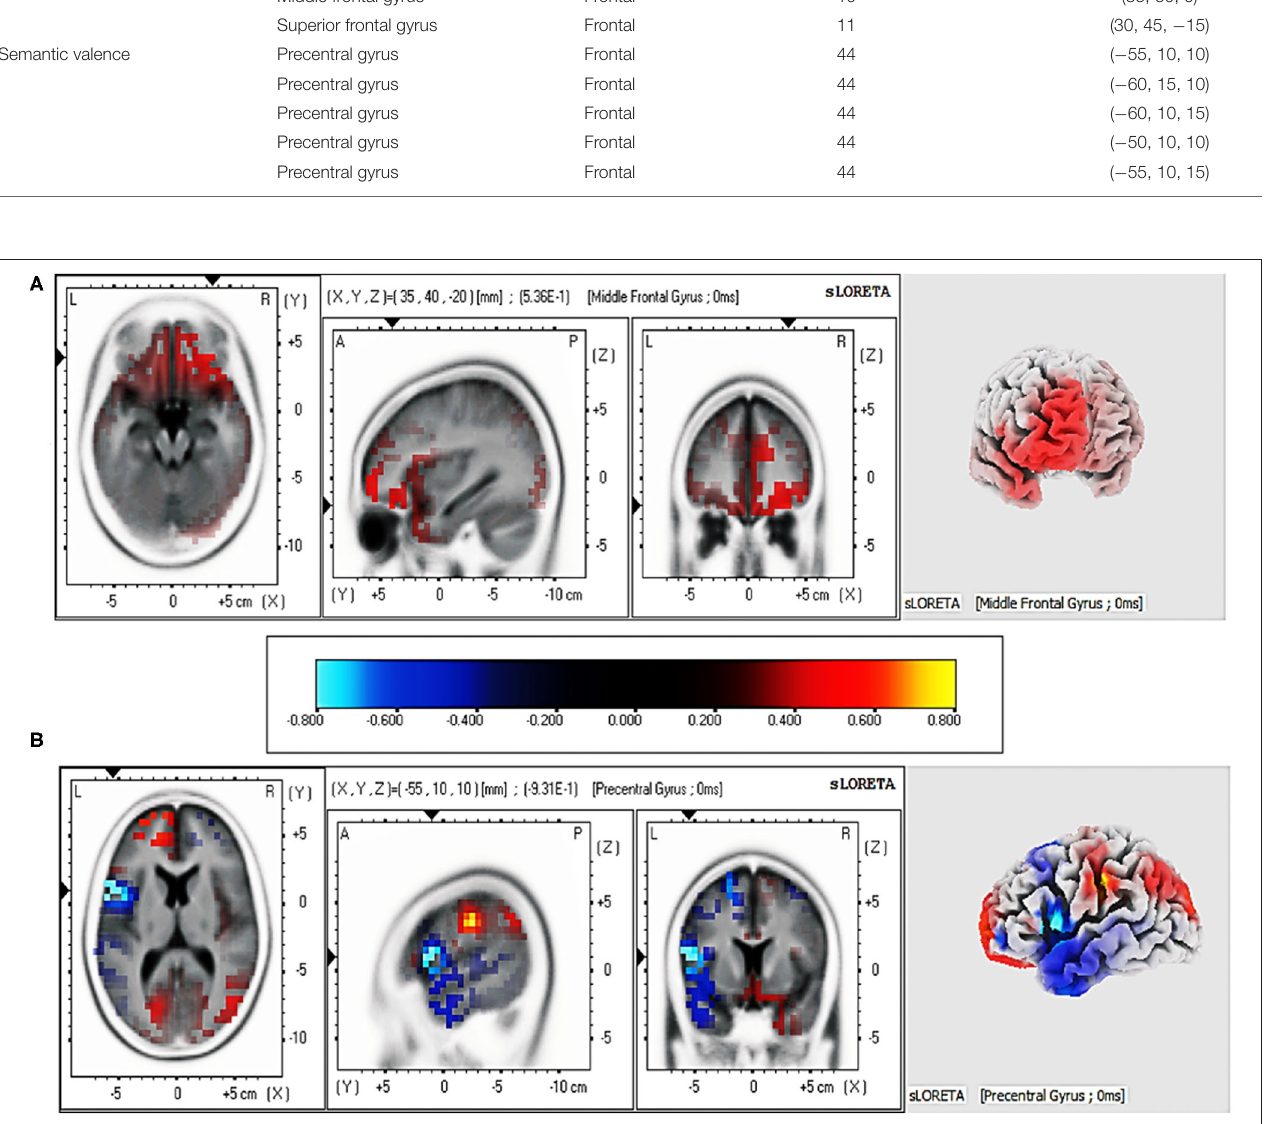
FIGURE 4 | Regions with the most significant difference in current intensity between pre-test and post-test from sLORETA at 1,000–2,500ms for two groups. (A) Brain regions activated by affective valence. (B) Brain regions activated by semantic